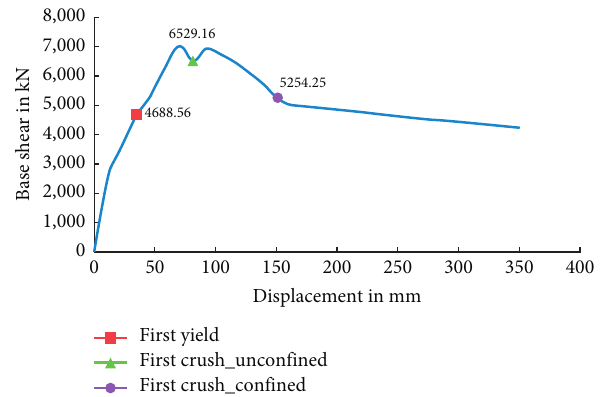
Figure 11: Damage pattern of full RC-infilled frame in X direction.